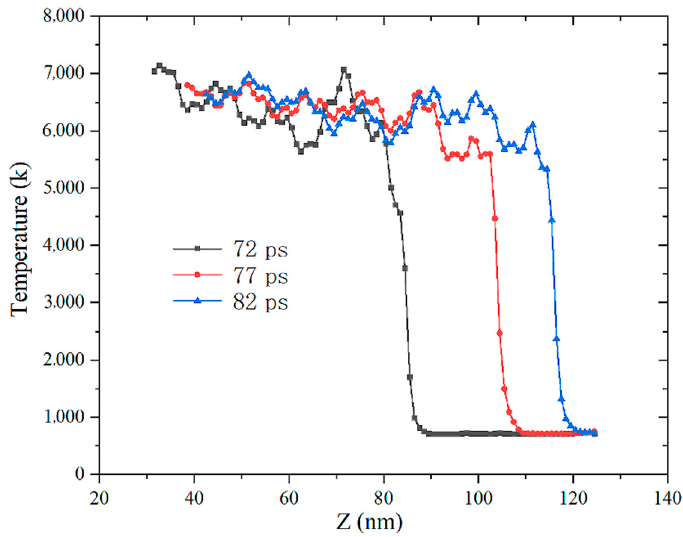
Figure 17. Temperature distribution at 1400m/s impact velocity.